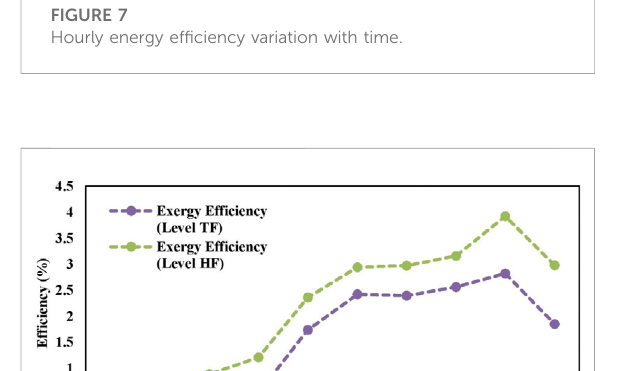
FIGURE 9 Maximum and average value of energy and exergy ef fi